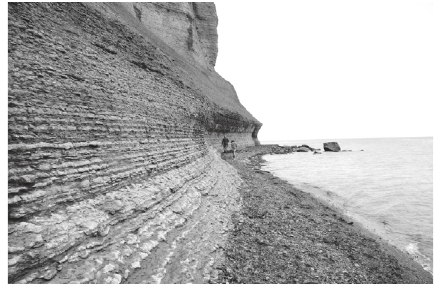
Figure 1: Limestone-marl rhythmites from the Vaur´eal formation (Baie de la Tour, Anticosti Island, Qu´ebec), dating from the Katian Stage (Upper Ordovician). The two walkers give an idea of the scale of the formation. Picture provided by Andr´e Desrochers.